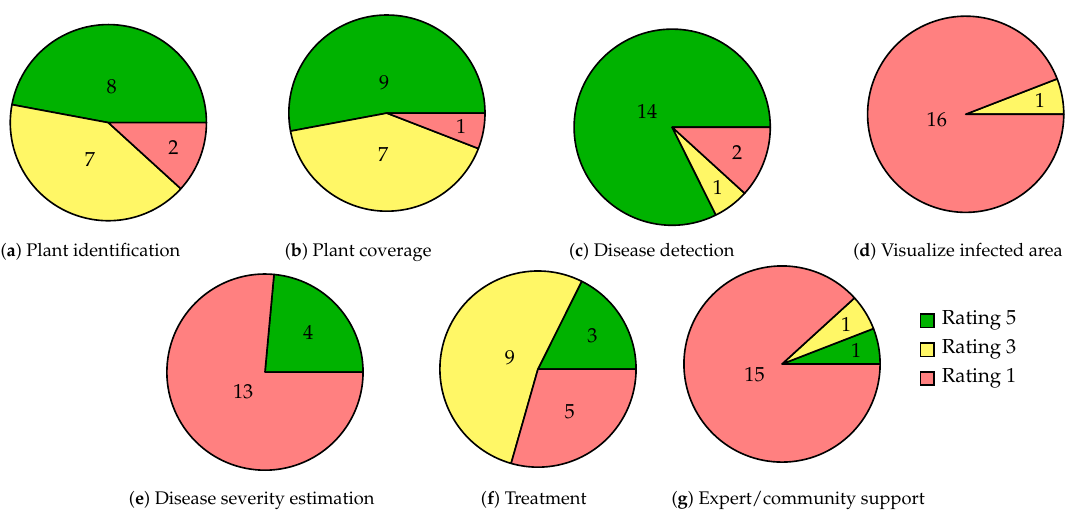
Figure 3. Representation of specific functionality rating ratio.